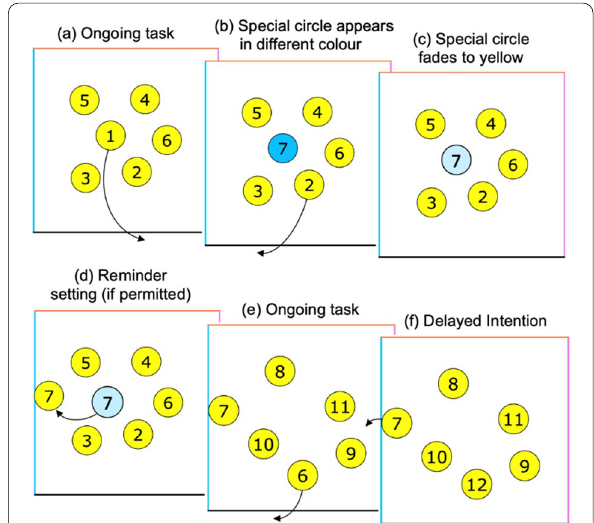
Fig. 1 Illustration of the optimal reminders task. Note Example trial of the optimal reminders task. a Participants were instructed to drag circles to the bottom edge of a box in sequential order. Each time a circle was moved onto an edge, it disappeared from the screen and the next circle in sequence emerged; b Sometimes, new circles were initially highlighted in a different color, indicating a delayed intention to drag the special circle to the same‑colored edge when reached in sequence; c A special circle’s color faded back to yellow two seconds after appearance. d If permitted, participants set reminders by instantly dragging the special circles near their intended edge when they emerged on the screen; e Participants carried on with the task of dragging circles to the bottom of the box; f After dragging the circles in sequential order, they could then execute the delayed intention to drag the special circle to its intended